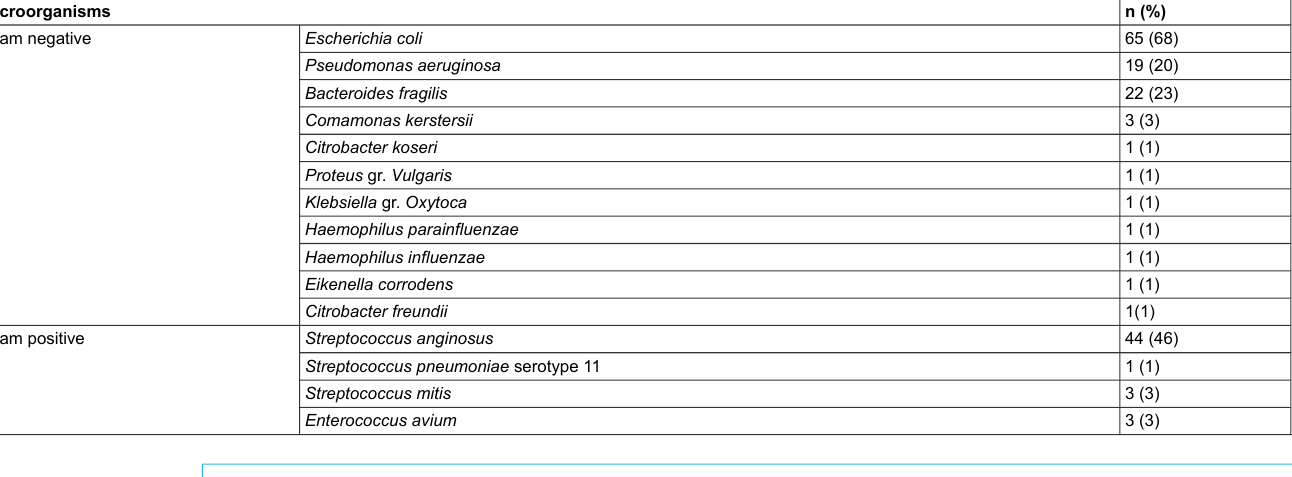
Figure 1: Microorganisms identified in cases of complicated appendicitis (displayed as a percentage per year). This bar chart shows that the most common microorganism found was Escherichia coli peaking at 86% in 2018.